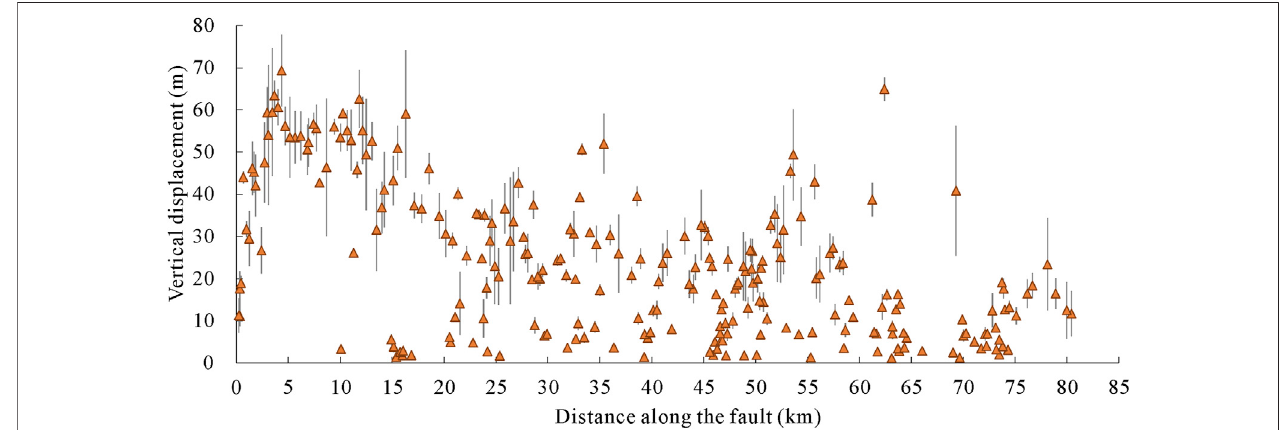
FIGURE 6 | Distribution of all vertical displacement measurements against their distance along the fault strike.